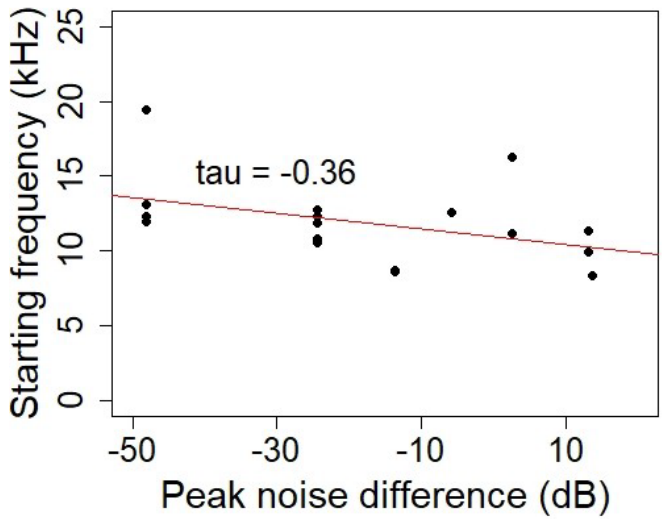
Figure 3. Scatter plots and linear best-fit lines of the starting frequency of the whistles of the coastal ecotype in function of the peak noise difference.